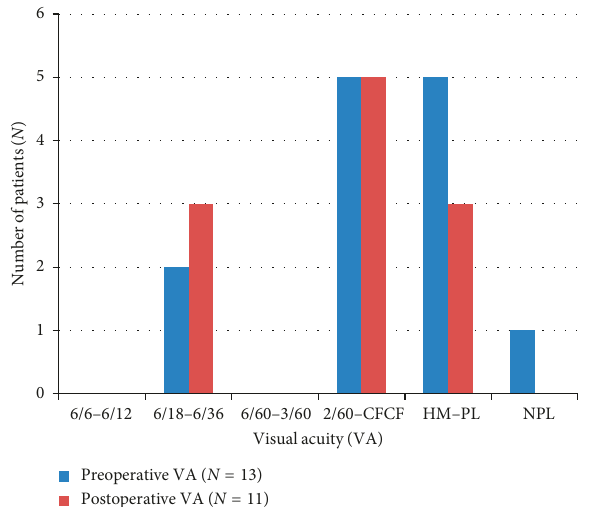
Figure 1: Comparison of visual acuity pre- and postoperatively.